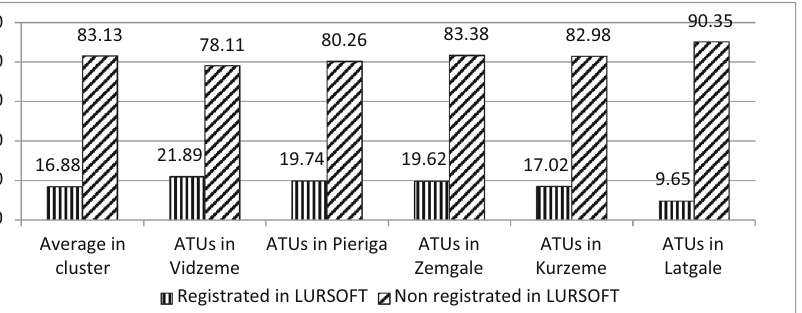
Figure 1: Section A economically active statistical units for Cluster 7 broken down by region, %. Source: authors ’ calculations based on LURSOFT and CSB data for 2017.